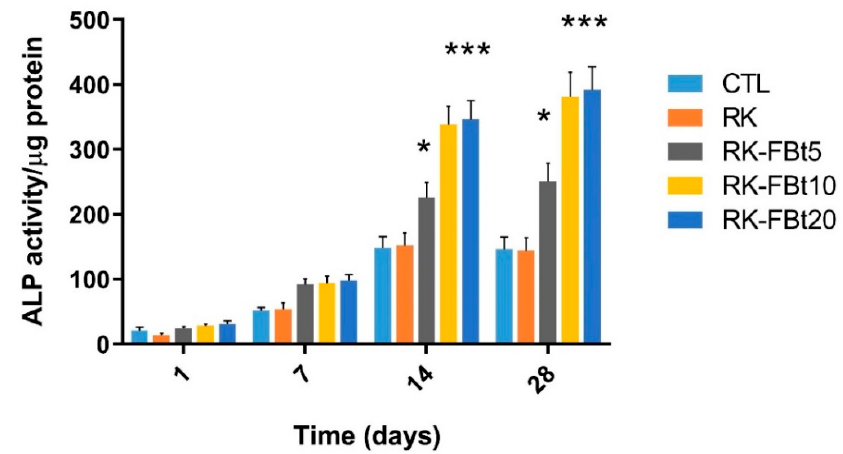
Figure 11. Alkaline phosphatase (ALP) activity of STRO-1+ cells cultured for 28 days on RK-FBt resins. Cell cultured onto tissue culture polystyrene (CTL) or on commercial light-activated restorative materials (RK) were used as controls. * P < 0.05 versus CTL and RK; *** P < 0.001 versus CTL, RK, and RK-FBt5; The bars represent means ± SD ( n = 3).